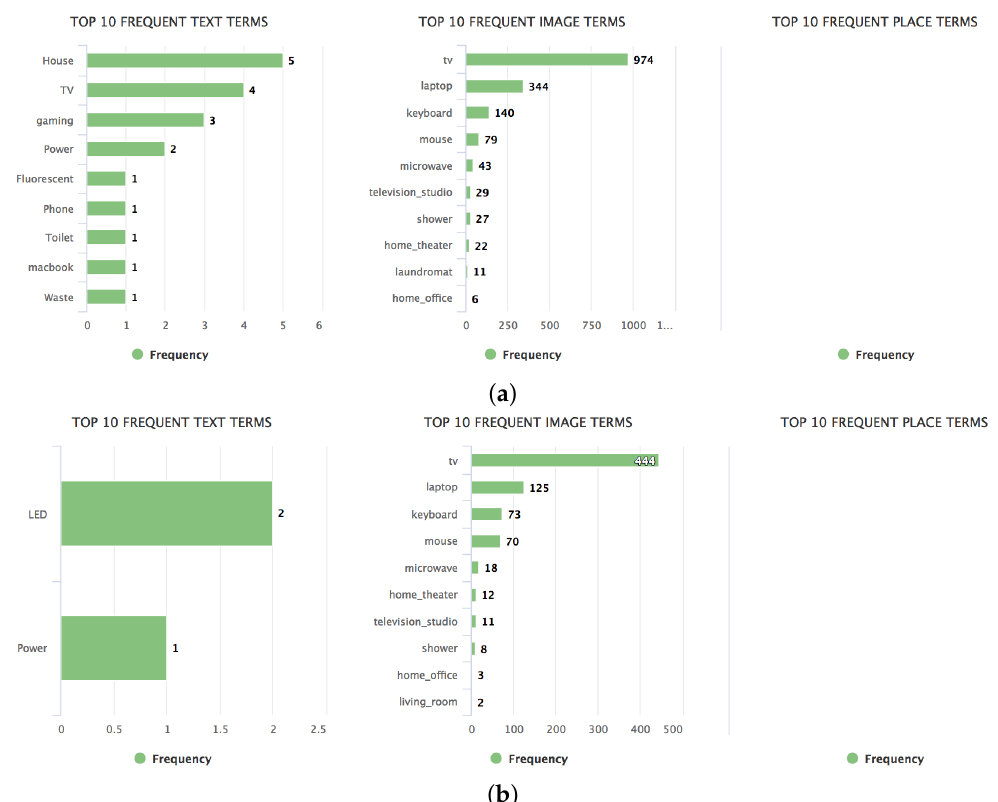
Figure 10. Bar charts visualizing the most occurring terms in social media posts classified to dwelling activities in Amsterdam ( a ) and Istanbul ( b ). For readability purposes, in the figures we show only English